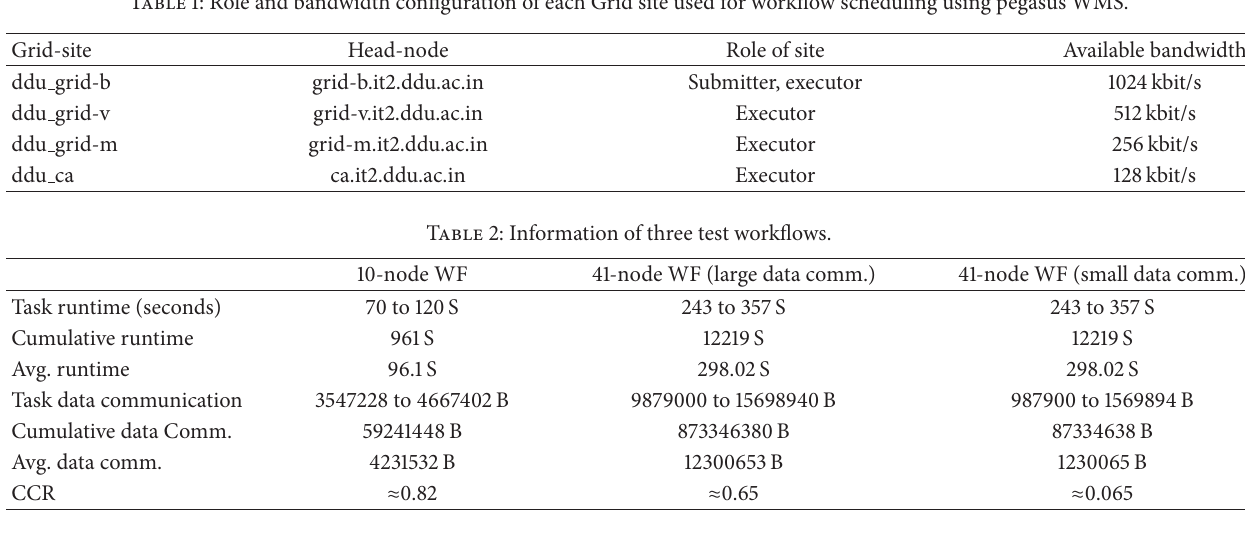
Table 1: Role and bandwidth configuration of each Grid site used for workflow scheduling using pegasus WMS.